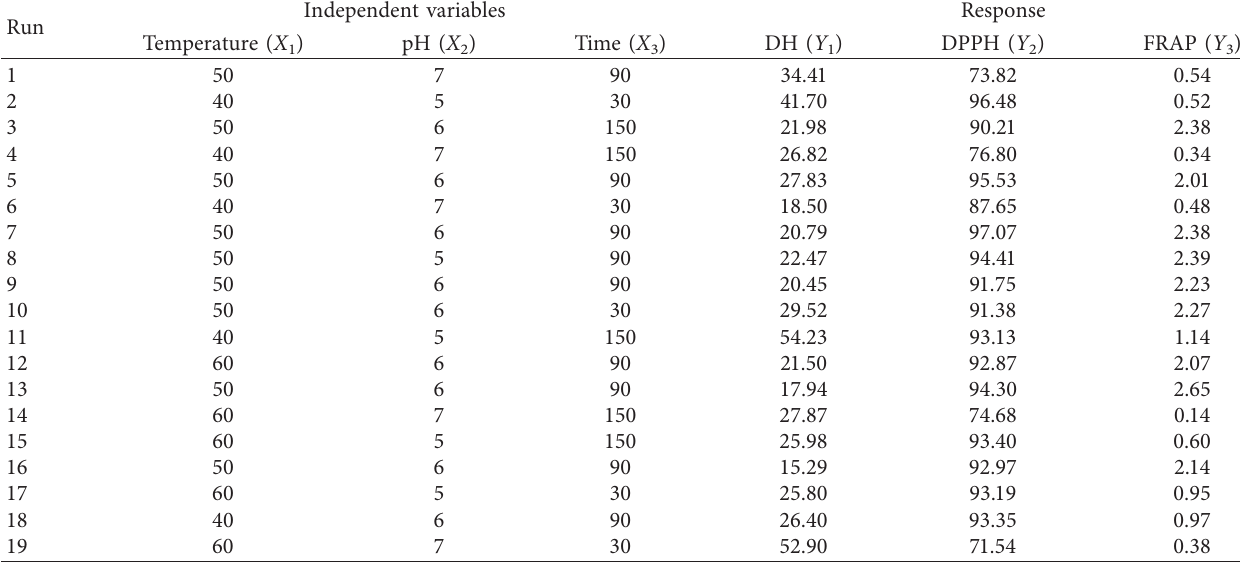
Table 1: Hydrolysis experiments and corresponding responses.